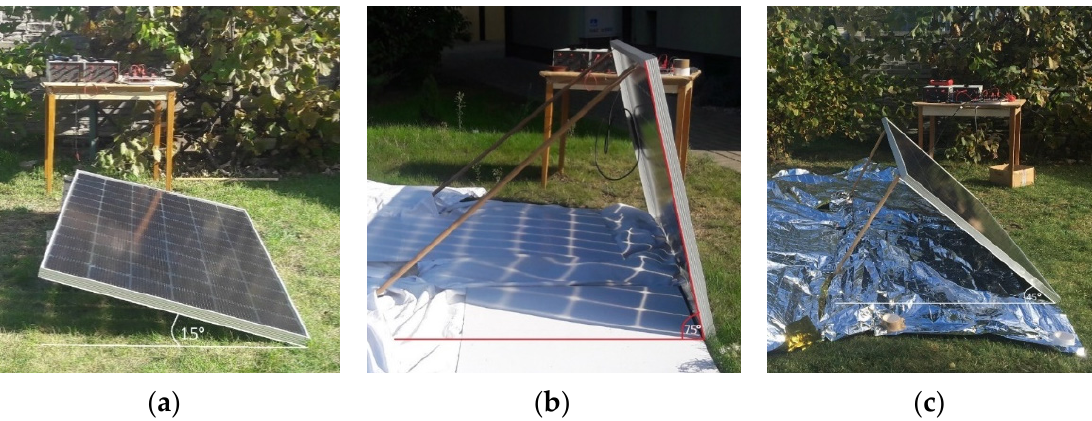
Figure 5. The horizontal-plane insolation in Poland [38].